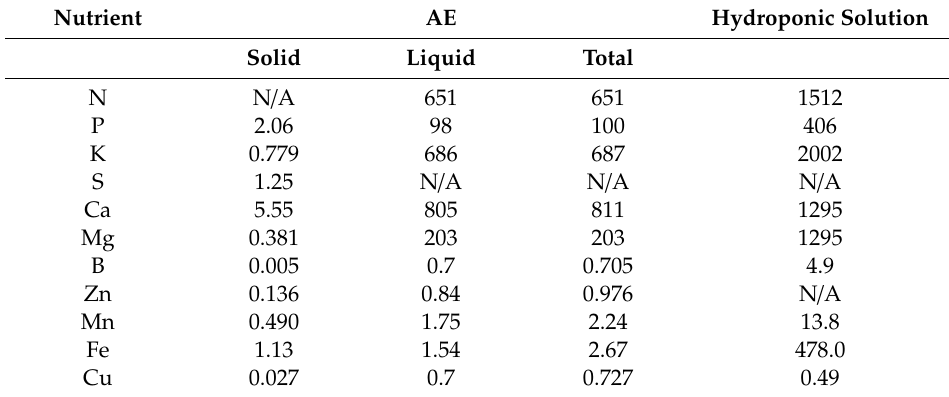
Table 12. Comparison of daily nutrient supply (mg) from aquaculture e ffl uent z (AE) and hydroponic solution y based on irrigation rate of 7 L